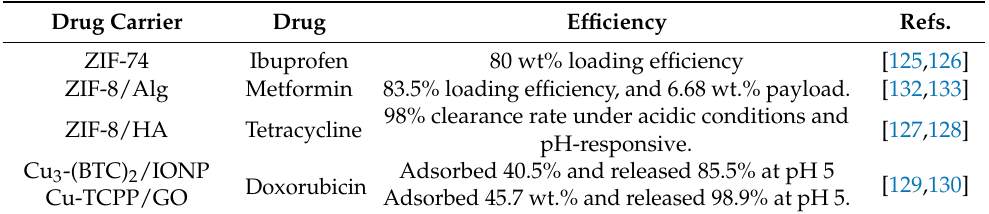
Table 1. Copper and zinc in metal–organic framework loading with drugs and their performances. Drug Carrier Drug Efficiency Refs. ZIF-74 Ibuprofen 80 wt% loading efficiency [125,126] ZIF-8/Alg Metformin 83.5% loading efficiency, and 6.68 wt.% payload. [132,133] 98% clearance rate under acidic conditions and ZIF-8/HA Tetracycline [127,128] pH-responsive. Cu 3 -(BTC) 2 /IONP Adsorbed 40.5% and released 85.5% at pH 5 [129,130] Doxorubicin Cu-TCPP/GO Adsorbed 45.7 wt.% and released 98.9% at pH